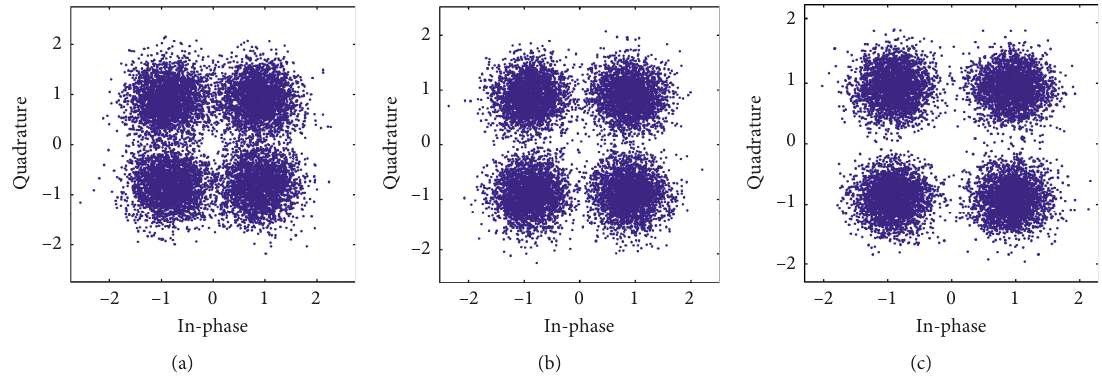
Figure 6: The measured CIRs for VS02: (a) the CIR for the pressure channel; (b) the CIR for the v (d) the temporal coherence of measured CIR.